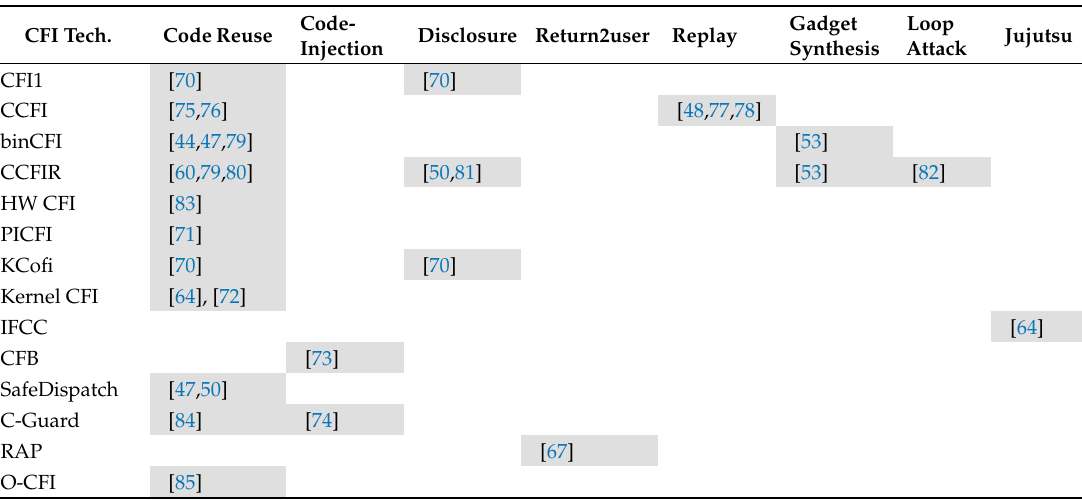
Table 2. State of the art of the attacks bypassing